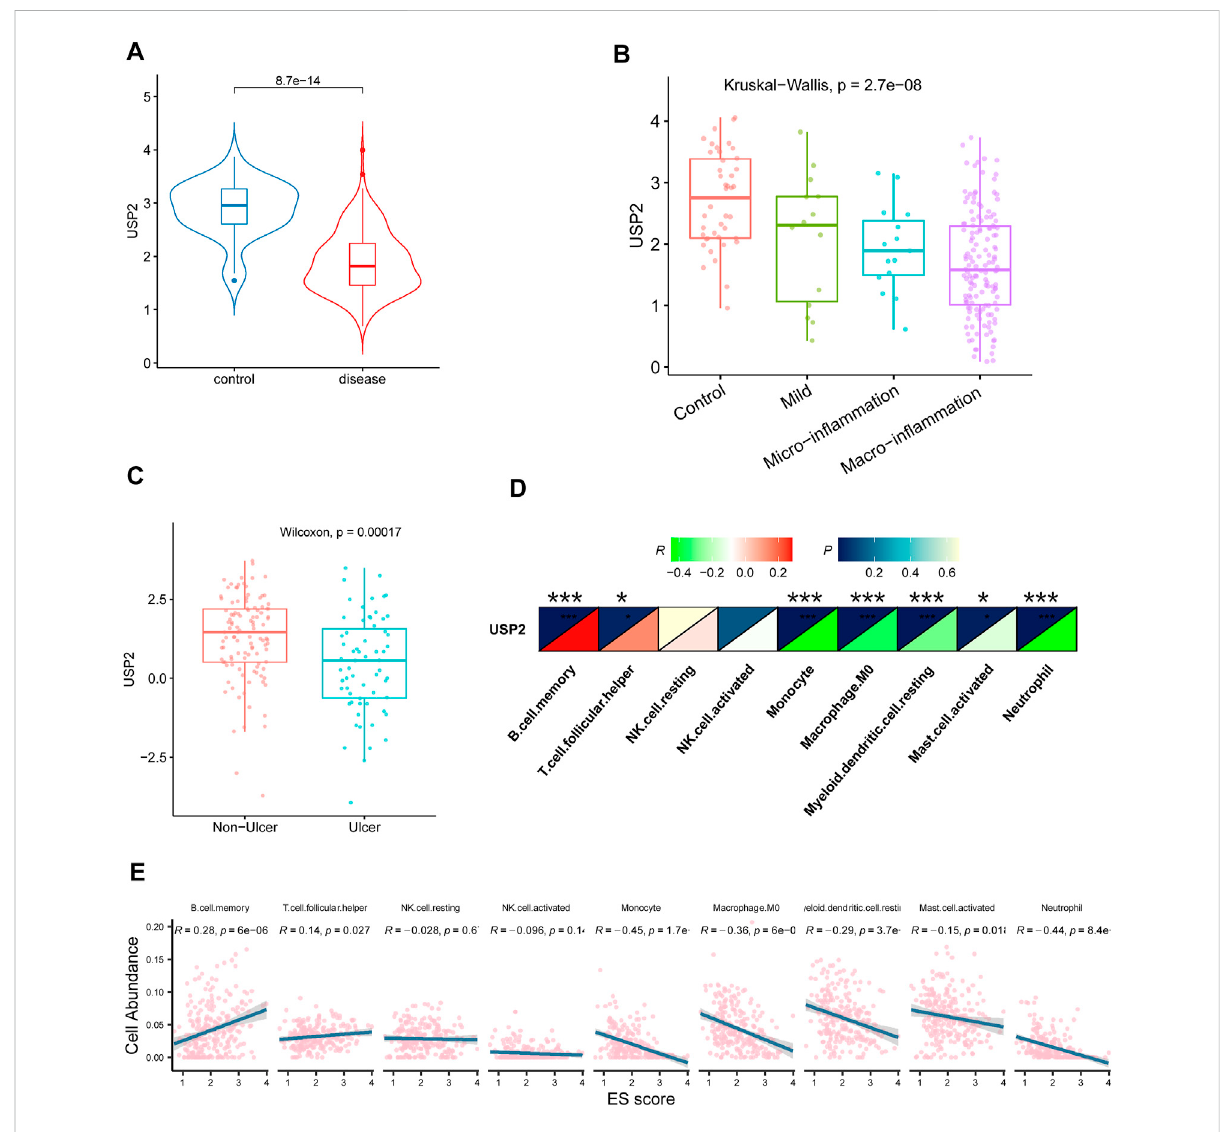
FIGURE 4 Association of USP2 with CD. (A) USP2 was also downregulated in CD compared with the control group in an independent cohort of CD patientsfromGSE57945. (B) USP2 wasassociatedwiththeseverityofdisease;theexpressionofUSP2decreasedasthediseaseprogressed. (C) USP2 wasdownregulatedinCDwithulcersthanwithoutulcers. (D – E) USP2 wasnegativelycorrelatedwithmonocyte,M0macrophage,myeloiddendritic cell, activated mast cell, and neutrophil whereas positively correlated with B cell and T cell follicular